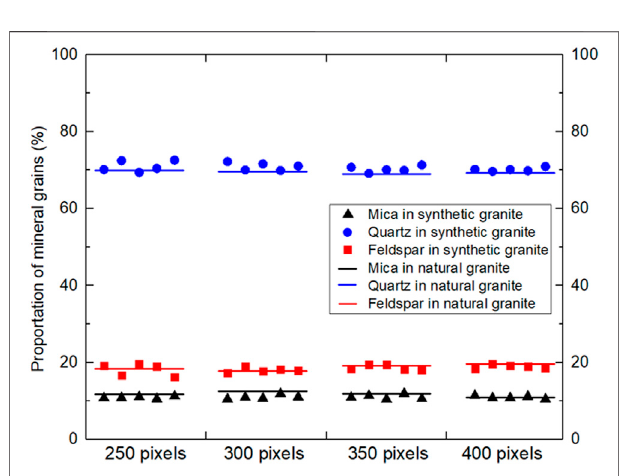
FIGURE 10 | Proportions of mineral grains in multi-scale natural and synthetic granite.